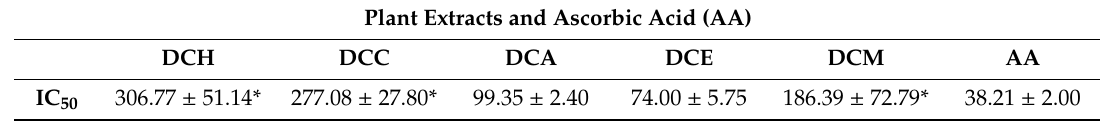
Table 3. Half maximal inhibitory concentration (IC 50 ; µ g / mL) of the plant extracts and ascorbic acid (AA) (control) toward DPPH free-radical scavenging activity. Plant Extracts and Ascorbic Acid